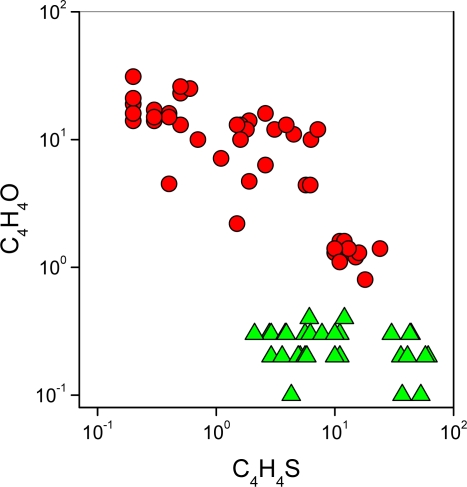
C4H4O vs. C4H4S binary diagram. Symbols as in Figure 2.